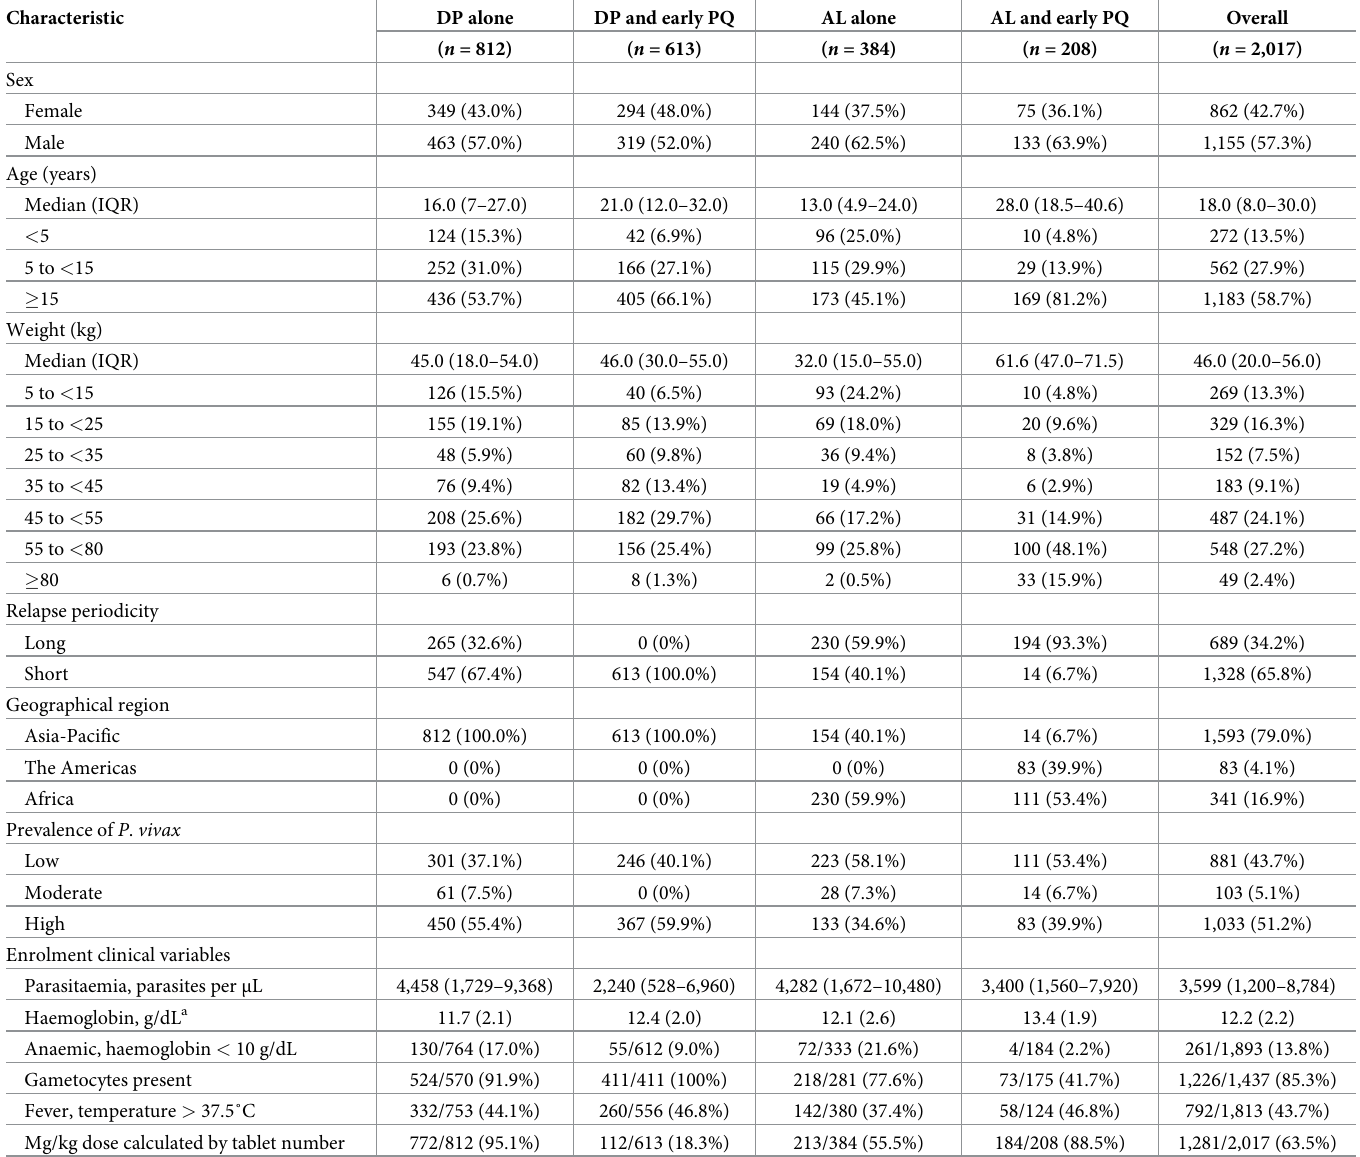
Table 1. Demographics and baseline